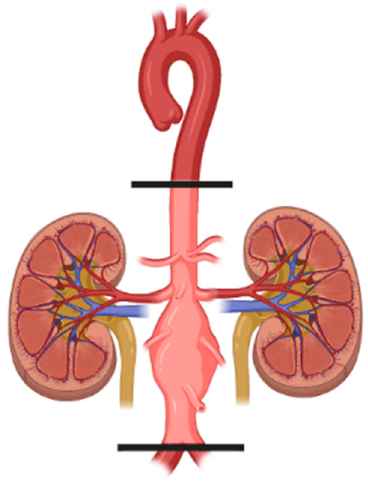
Figure 4. Surgically-induced ischemia during abdominal aortic aneurysm